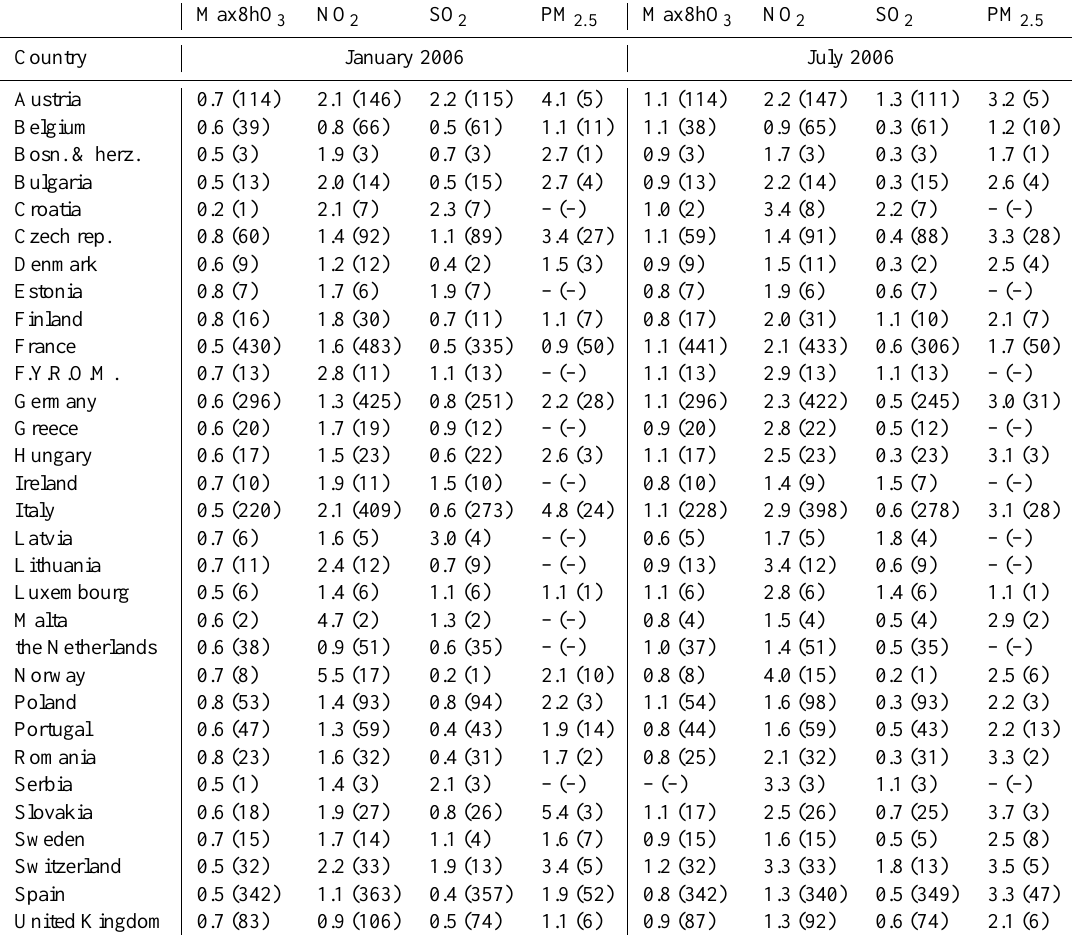
Table 3. Observed mean /Predicted mean concentration ratios for the European countries and the number of monitoring stations (in